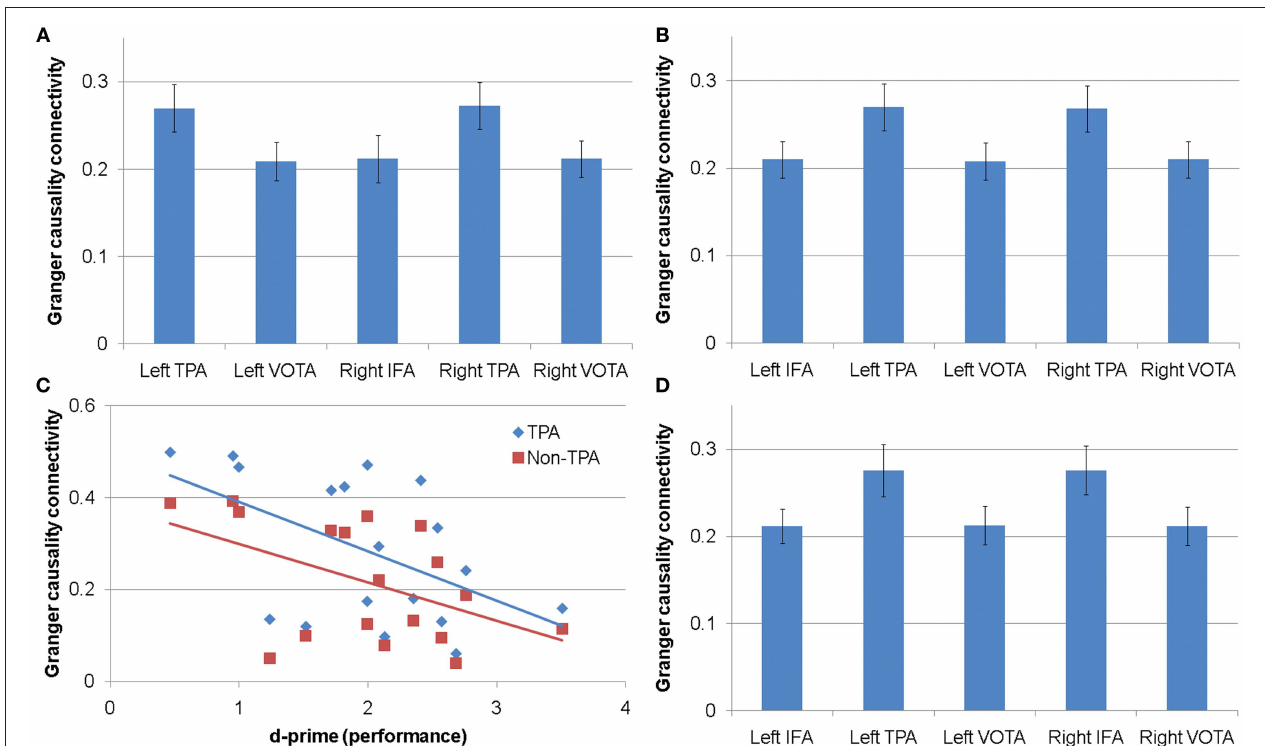
connectivity between the left IFA and temporoparietal (TPA) and non- temporoparietal (non-TPA) areas for the high gamma sub-band. (D) Connectivity between the right IFA and other cortical areas for the high gamma sub-band. VOTA, ventral occipital–temporal